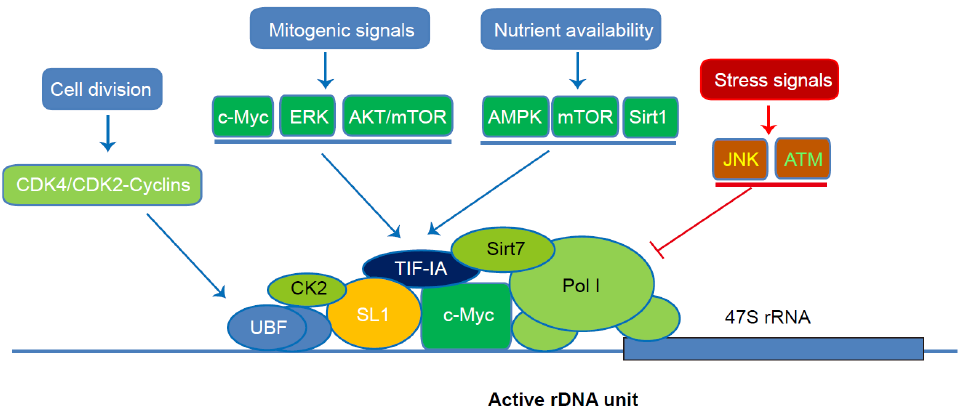
Figure 1. Coordinate regulation of Pol I-mediated transcription of rRNA by upstream signaling pathways. Multiple components of Pol I transcriptional machinery, such as UBF, SL1, TIF-IA and Pol I, are subjected to post-transcriptional modifications by various upstream regulators. These regulations coordinate the requirement of rRNA synthesis to cellular demand for ribosome biogenesis.